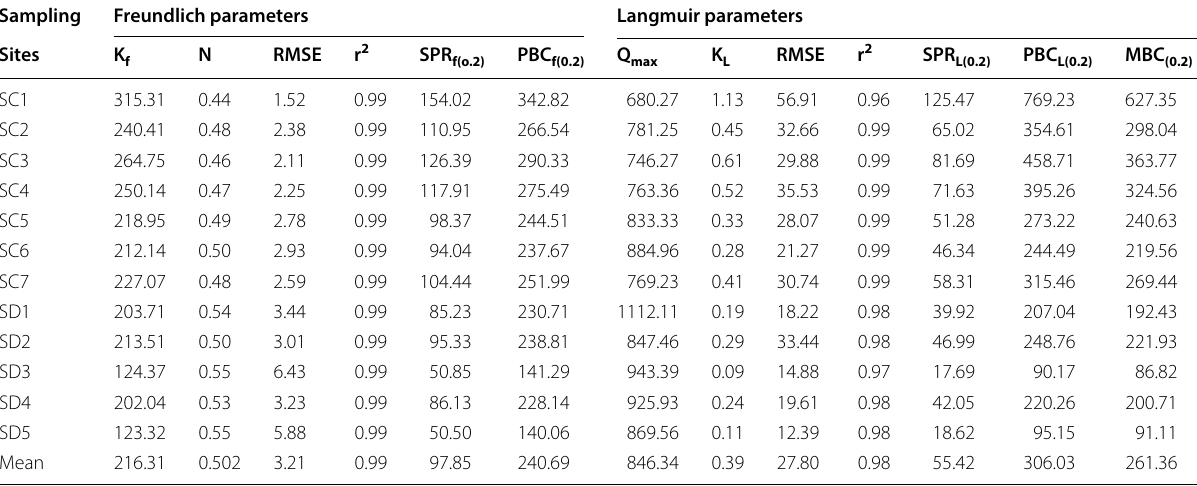
Table 3 The Freundlich and Langmuir model parameters, SPR, PBC, MBC, RMSE and r 2 values after 24 h equilibration